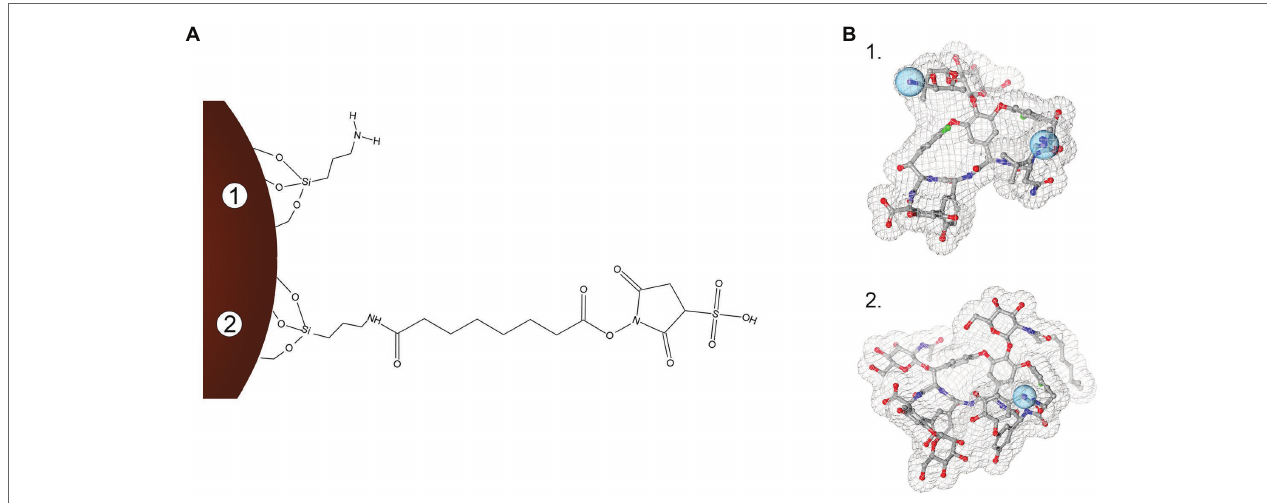
FIGURE 1 | Schematization of the conjugation chemistry used to link teicoplanin and vancomycin onto iron oxide nanoparticles (IONPs; not in scale). Panel A : Surface modification steps with APTES functionalization (1) and subsequent BS3 linker binding (2). Panel B : 3D molecular structures of vancomycin (1, PDB entry 1FVM) and teicoplanin (2, PDB entry 3VFK). Blue spheres indicate amine groups used for conjugating GPAs to BS3 moiety. In ( B ), GPA structures were rendered with 3D ProteinImager (Tomasello et al.,